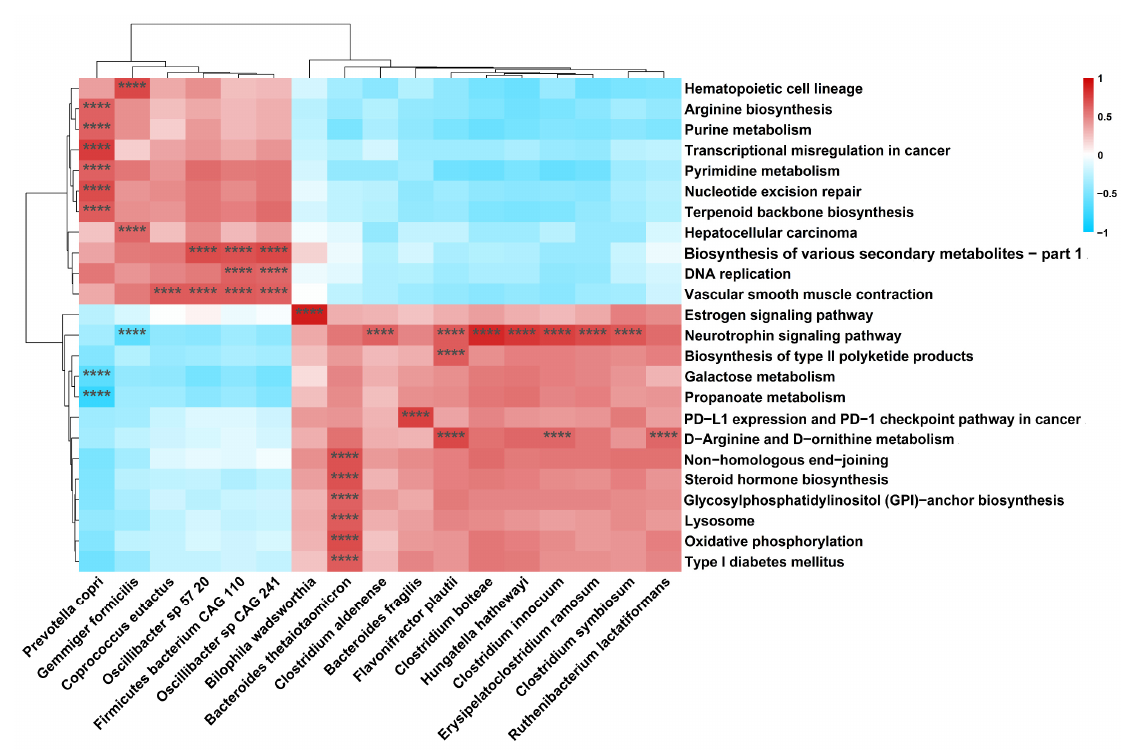
Figure 4. Heatmap of the correlations between bacterial species and metabolic pathways. The heatmap shows the species and metabolic pathways with the absolute values of Spearman ’s rank correlation coefficient |r s | > 0.6 and p -adj value < 0.05. ****, p -adj value < 0.001., *** p -adj value < 0.005., ** p -adj value < 0.01., * p -adj value < 0.05.